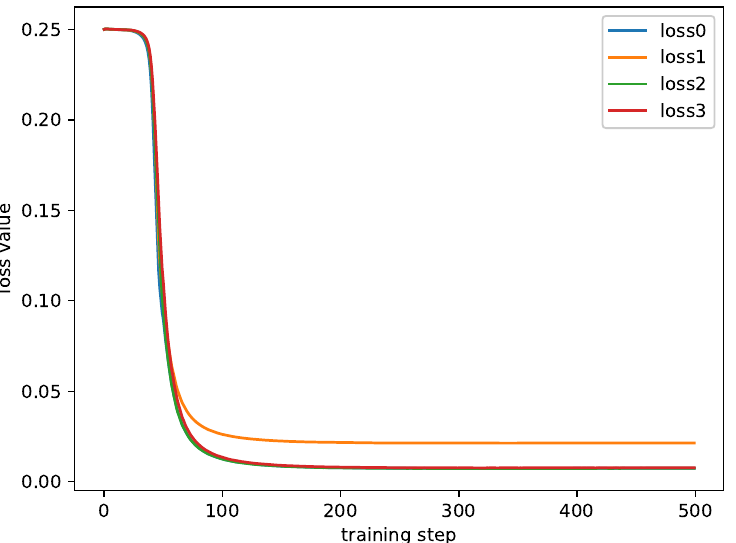
Figure 5. The training losses. The loss 0, loss 1, loss 2, and loss 3 are the training losses on the UCLA, UM, USM, and NYU sites,